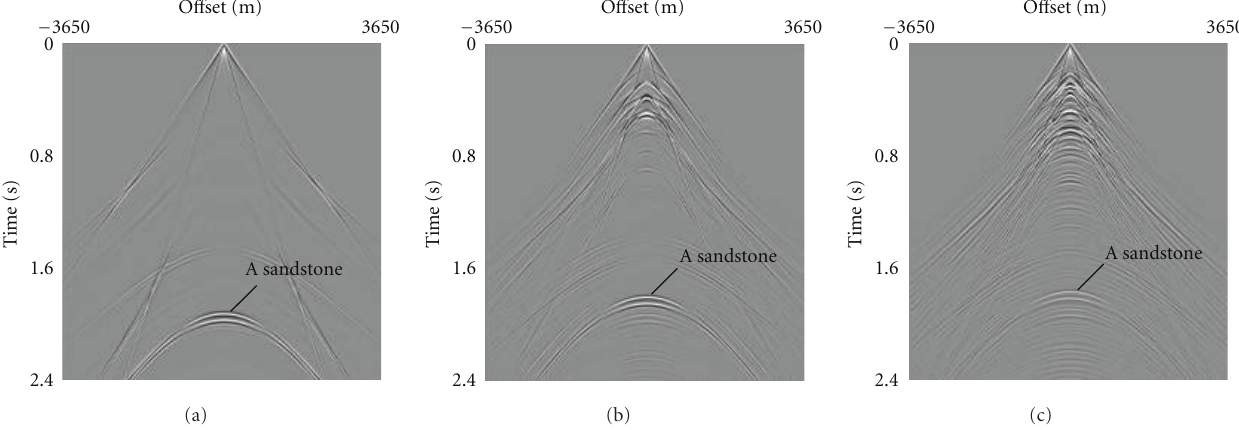
Figure 10: S-wavegather for the case of (a)Model 1a, (b) Model 1b, and (c) Model 1c, showsthat the primary reflection amplitude is stronger than the amplitude of multiples.